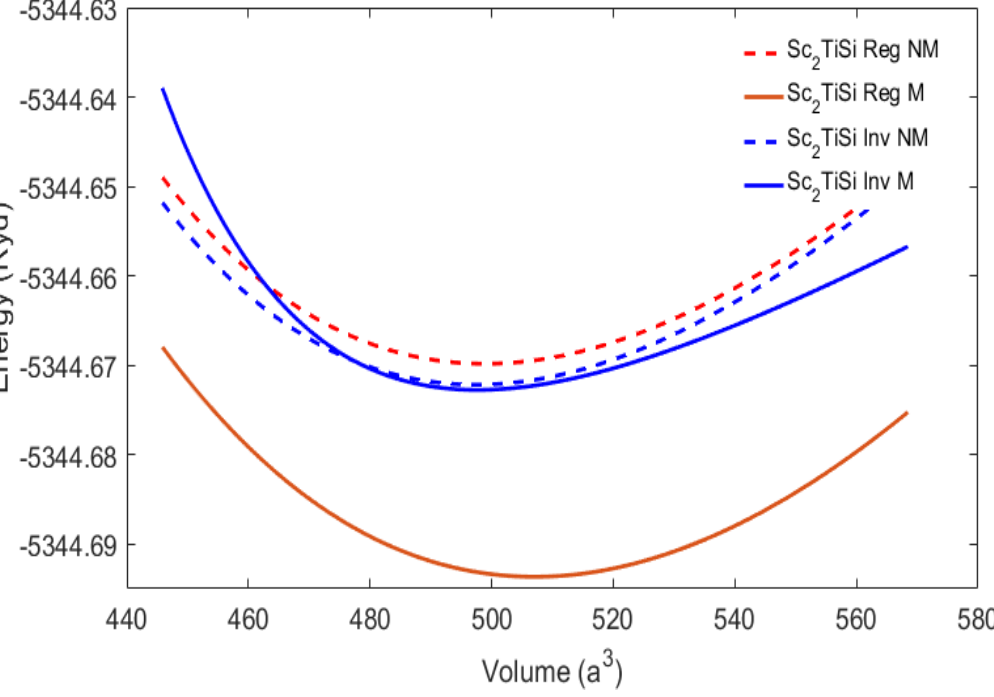
Figure 3. The total energy (Ry) versus volume (a.u 3 ) of non-magnetic, regular, and inverse Sc 2 TiSi Heusler. Table 1. The obtained lattice constant ( a ), bulk modulus ( B ), pressure derivative of the bulk modulus ( B ’), minimum energy ( E 0 ), and formation energy ( E f ) for the regular and inverse Heusler of both Sc 2 TiAl and Sc 2